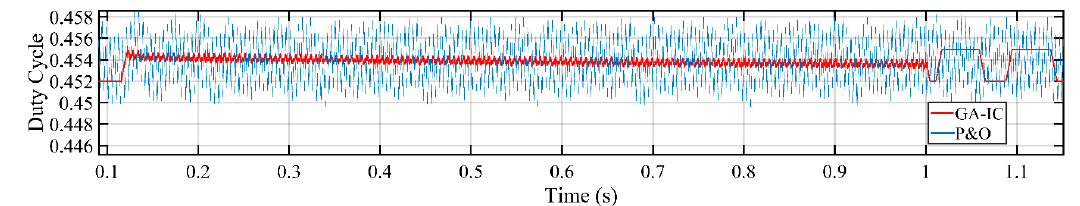
Figure 22. Case 2 duty cycle comparison of modified GA-IC vs. P&O.